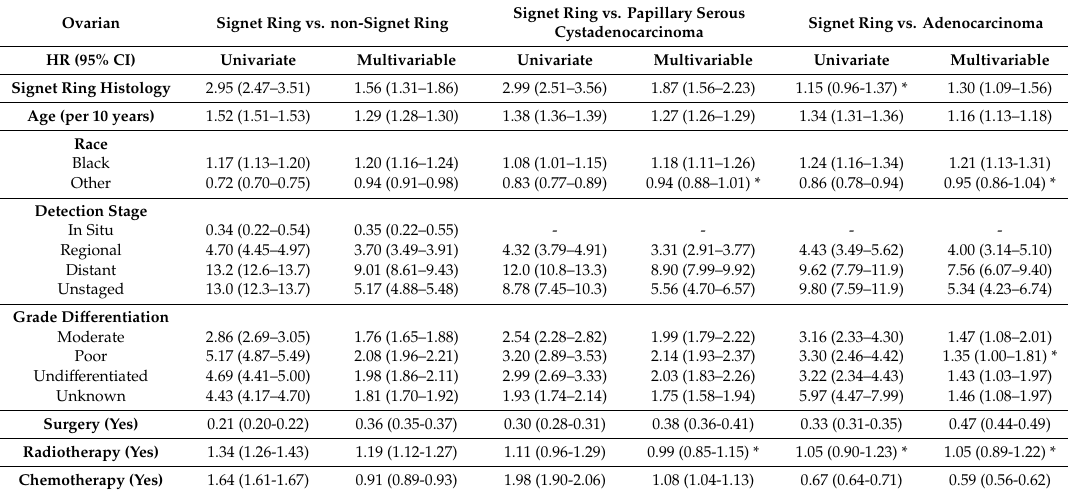
Table 24. Derived univariate and multivariable Cox-proportional hazard ratios (HR) of mortality for ovarian cancers. Ovarian Signet Ring vs. non-Signet Ring Signet Ring vs. Papillary Serous Cystadenocarcinoma Signet Ring vs. Adenocarcinoma HR (95% CI) Univariate Multivariable Univariate Multivariable Univariate Multivariable